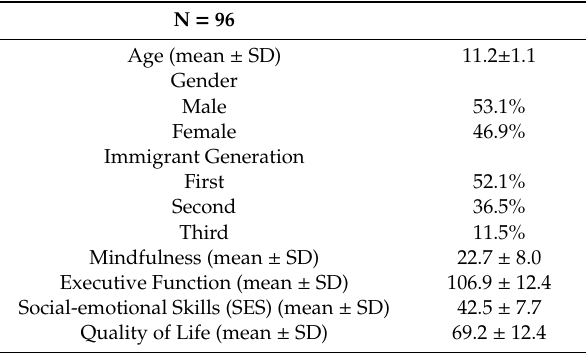
Table 1. Descriptive statistics of sample characteristics.